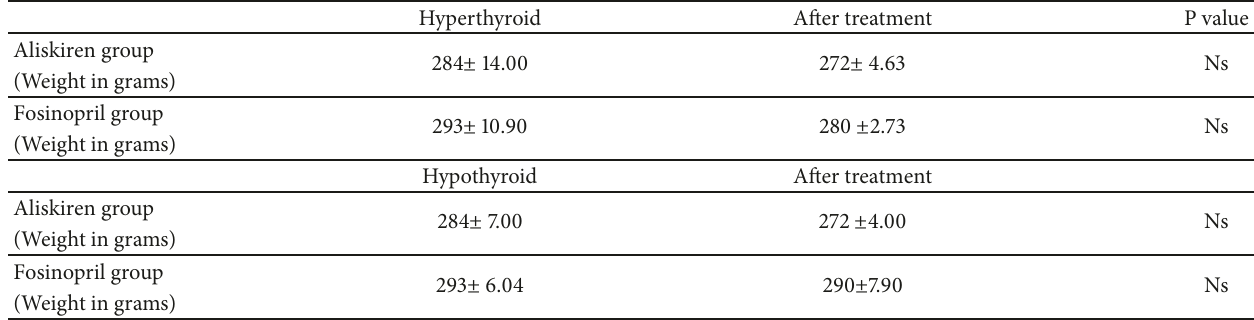
Table 11: Mean and SE (standard error) of weights of rats (in grams). Hyperthyroid, hypothyroid, and after treatment with Aliskiren and Fosinopril. Hyperthyroid After treatment P value Aliskiren group 284 ± 14.00 272 ± 4.63 Ns (Weight in grams) Fosinopril group 293 ± 10.90 280 ± 2.73 Ns (Weight in grams) Hypothyroid After treatment Aliskiren group 284 ± 7.00 272 ± 4.00 Ns (Weight in grams) Fosinopril group 293 ± 6.04 290 ± 7.90 Ns (Weight in grams) NS: